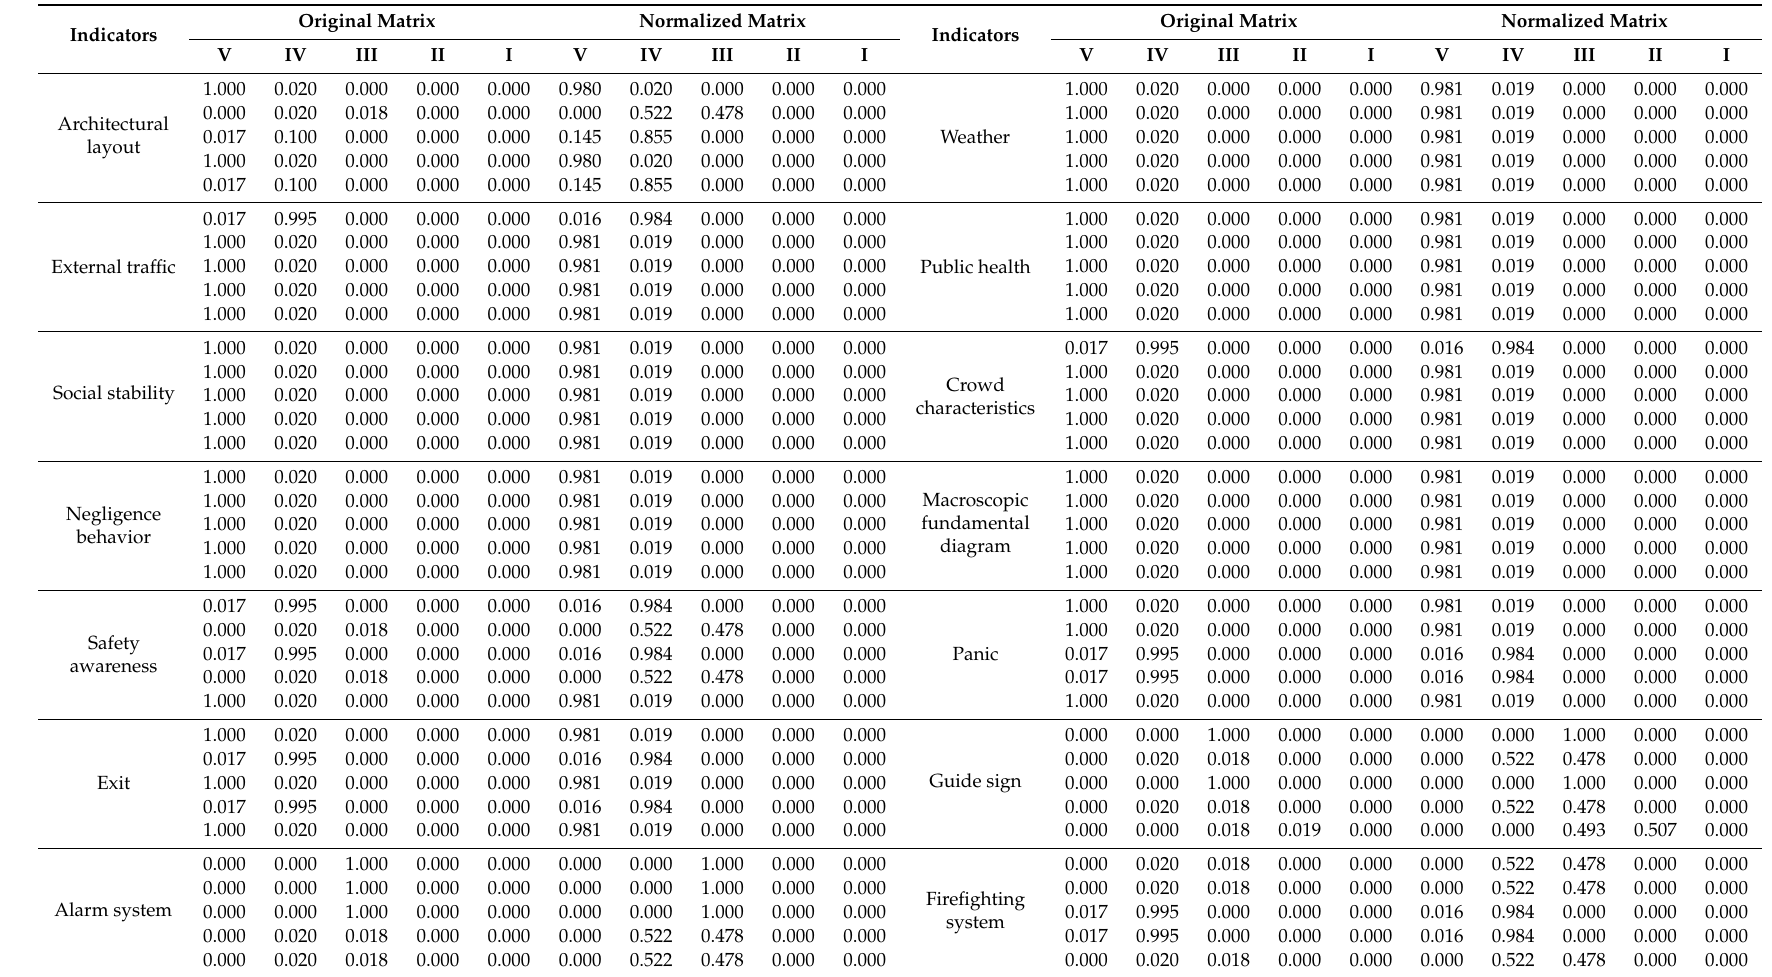
Table A1. Results of original matrix and